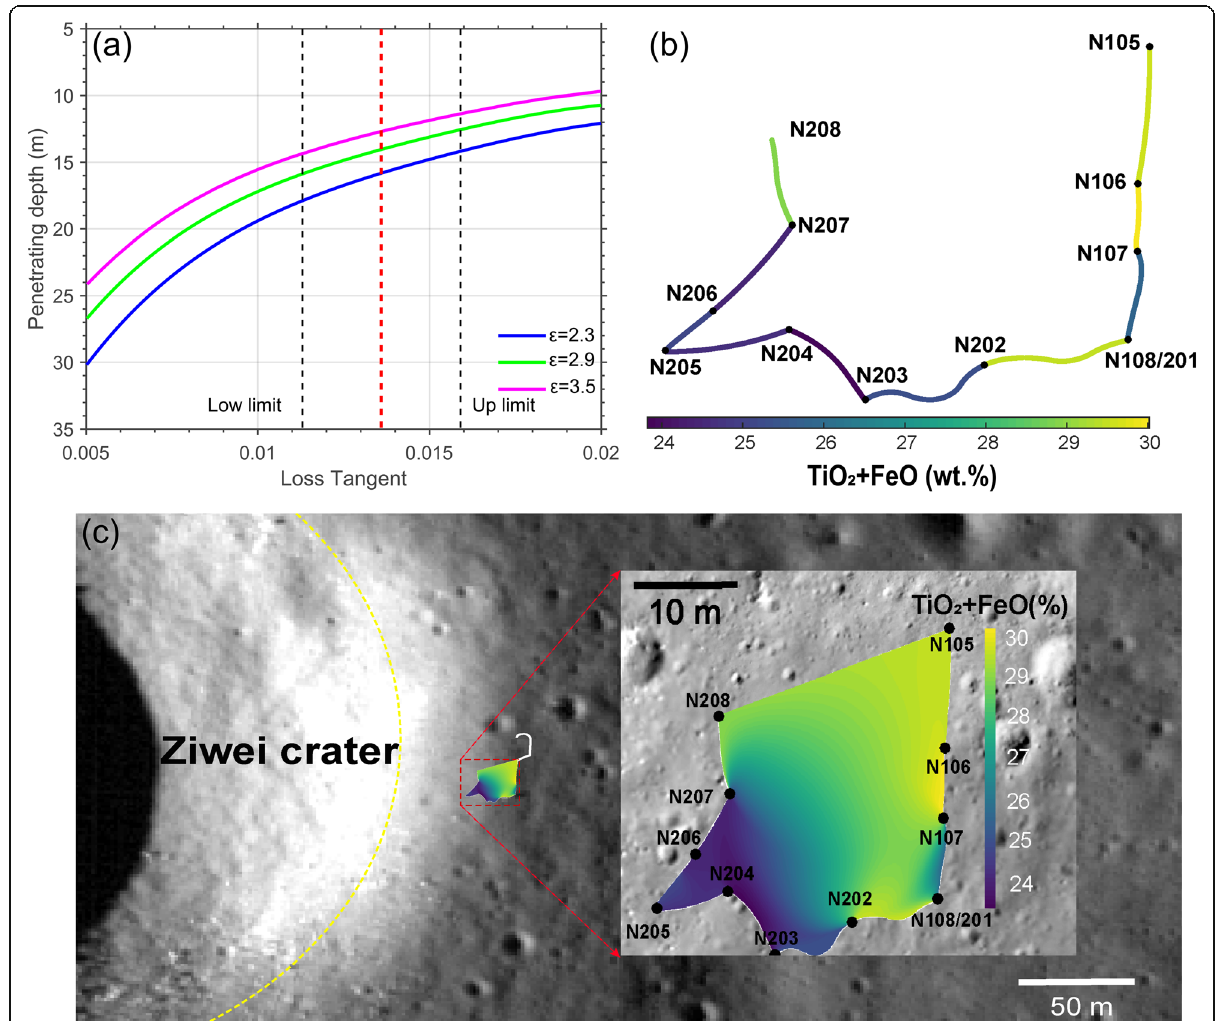
Fig. 5 a The relationship between the different loss tangent and the penetration depth of the high frequency channel (Xing et al. 2017). The pink, green and blue lines show the electromagnetic wave propagation in media that have a relative permittivity of 2.3, 2.9, and 3.5, respectively. The red dashed line shows the position of our estimated average loss tangent, and the rest two dashed lines correspond to the lower and upper limits of our estimated loss tangent, respectively. b The estimated content of TiO 2 + FeO from the navigation points N105 to N208 along the route of Yutu. c An interpolated trend map for the content of TiO 2 + FeO in the traverse region of Yutu. This map is based on the measurement shown in panel b using a natural neighbor interpolation method. The base map of the main frame is obtained by the Lunar Reconnaissance Orbiter (M102285549LE + RE; 1.66 m/pixel), and that for the inset is obtained by the descent camera onboard the CE-3 lander (image ID